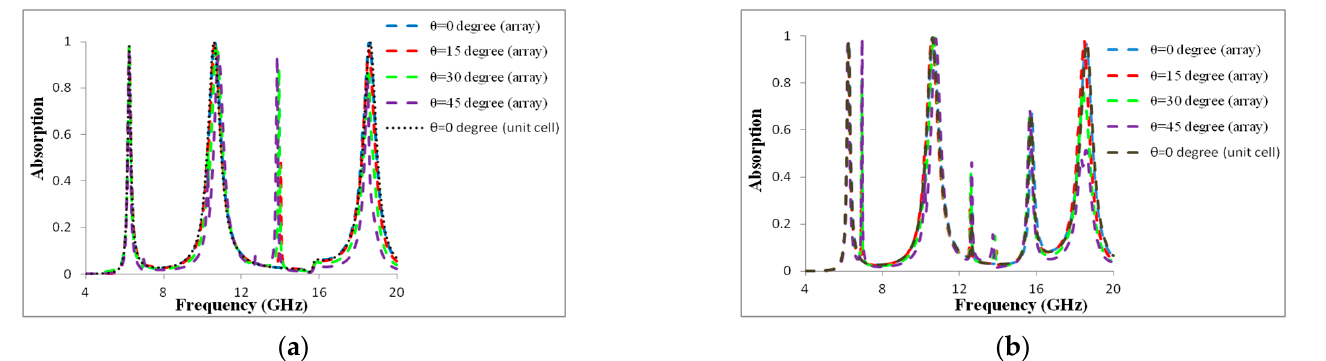
Figure 11. Absorption at ( a ) TE and ( b ) TM mode for a 1 × 2 array and unit cell.